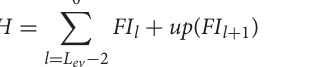
FI l represents the fused image data of the l th layer. W k , l represents the l th layer data of the k th weighted image. L k , l represents the l th layer data of the Laplacian pyramid of the k th multi-exposure image. L ev represents the total number of pyramid layers. N represents the number of images. The upper layer image of the fused pyramid is first upsampled, and then expanded and added to the lower layer image to obtain an image with the equal size of the image to be fused as follows.